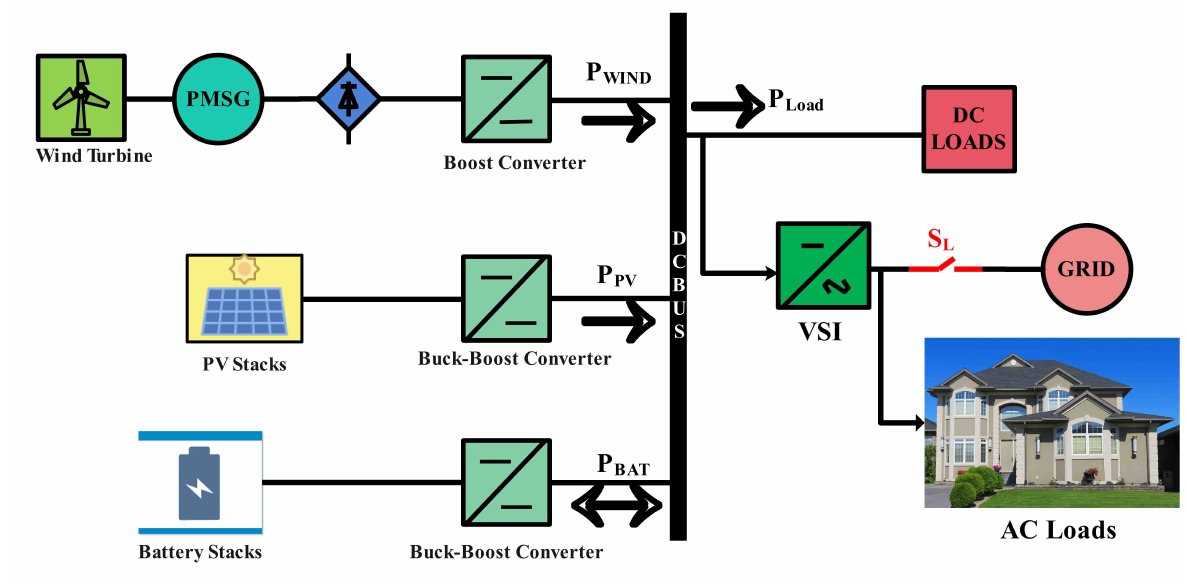
Figure 1. Hybrid AC/DC